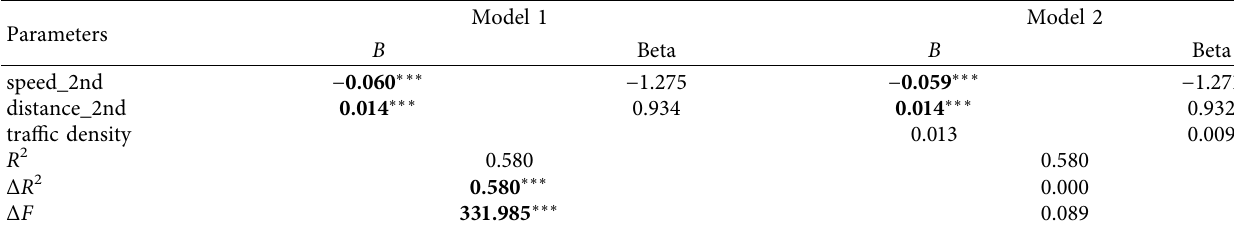
Table 12: Results of the maximum deceleration based on free-driving